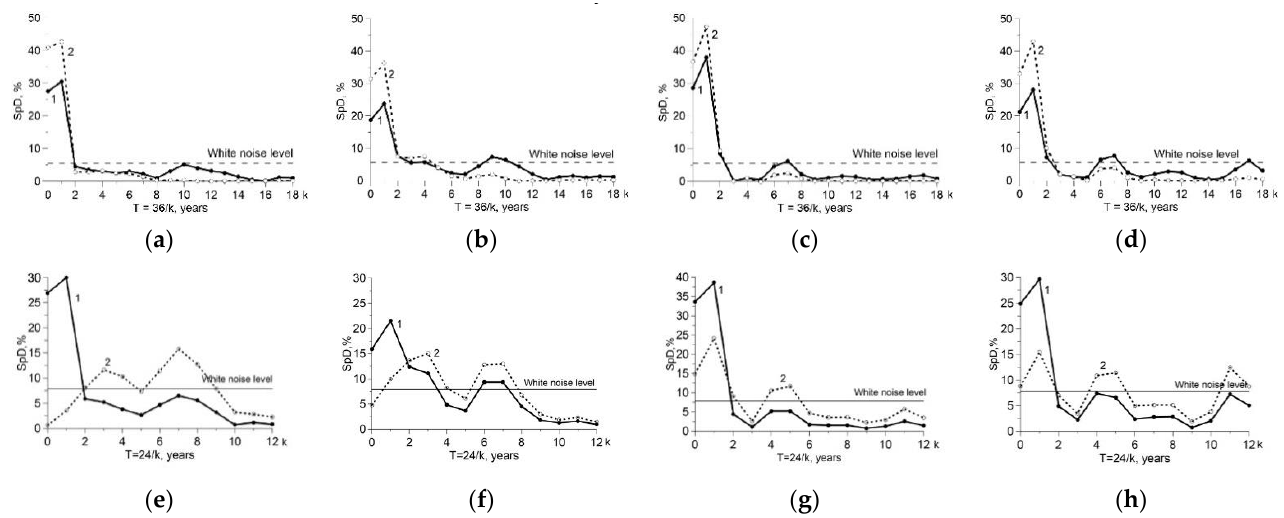
Figure 10. Spectral densities (SpD) of variability of climate characteristics at low latitudes and in the Arctic before and after smoothing with a window of 3 years, and before and after the removal of trends. Upper row: SpD before (1) and after (2 — dotted line) smoothing ( a ) SAT in the region of 0 – 25° N in autumn, ( b ) TCWV in the region of 0 – 25° N in autumn, ( c ) SAT in the area of 70 – 87.5° N in winter, ( d ) TCWV in the area of 70 – 87.5° N in winter). Lower row: SpD before (1) and after (2 — dotted line) the removal of the trend ( e ) SAT in the area of 0 – 25° N in autumn, ( f ) TCWV in the area of 0 – 25° N in autumn, ( g ) SAT in the area of 70 – 87.5° N in winter, ( h ) TCWV in the area of 70 – 87.5° N in winter.